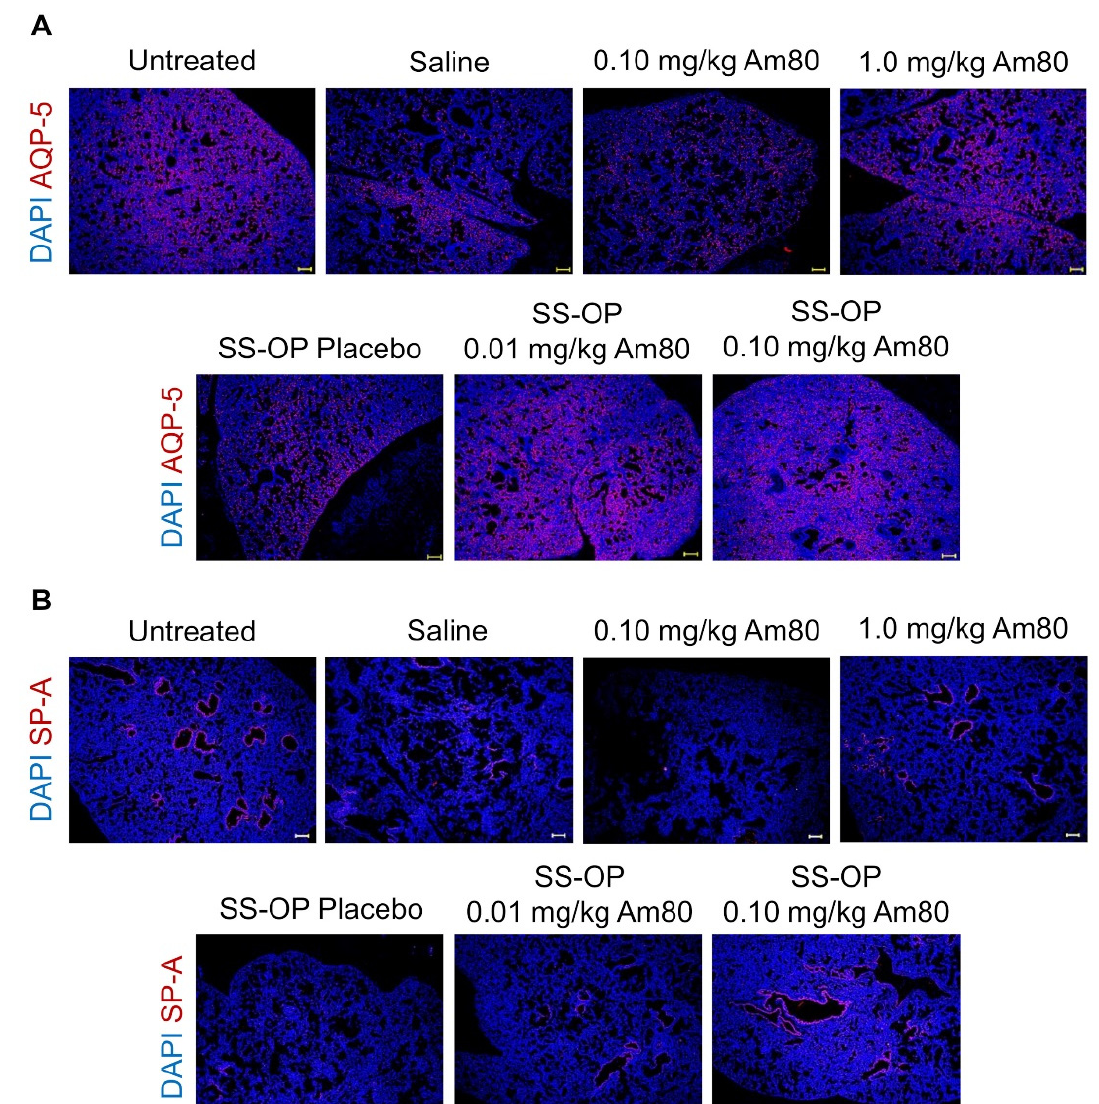
Figure 4. In vivo induction of differentiation by Am80-encapsulated SS-OP nanoparticles. Lung sections stained for ( A ) AQP-5 or ( B ) SP-A with Alexa Fluor 594, and DAPI nuclear staining observed using a BZ-9000 fluorescence microscope, ×4, Scale bar: 200 μ m.